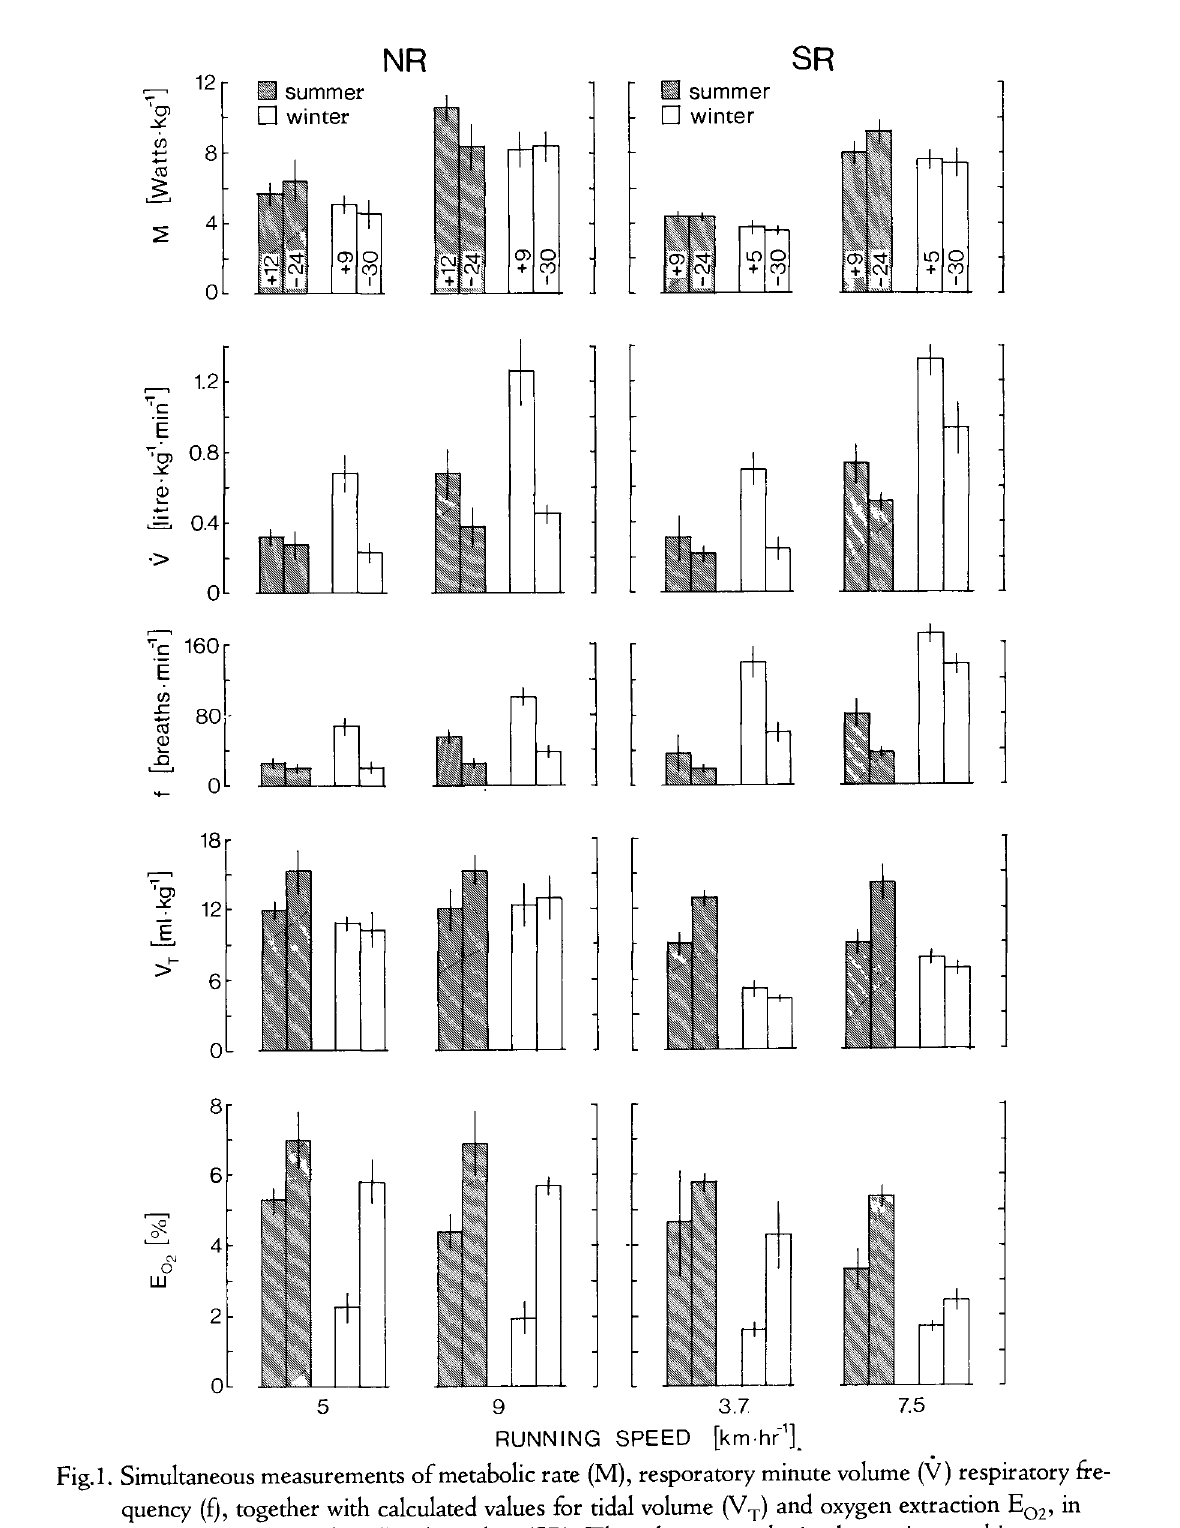
) and oxygen extraction E , in T Q 2